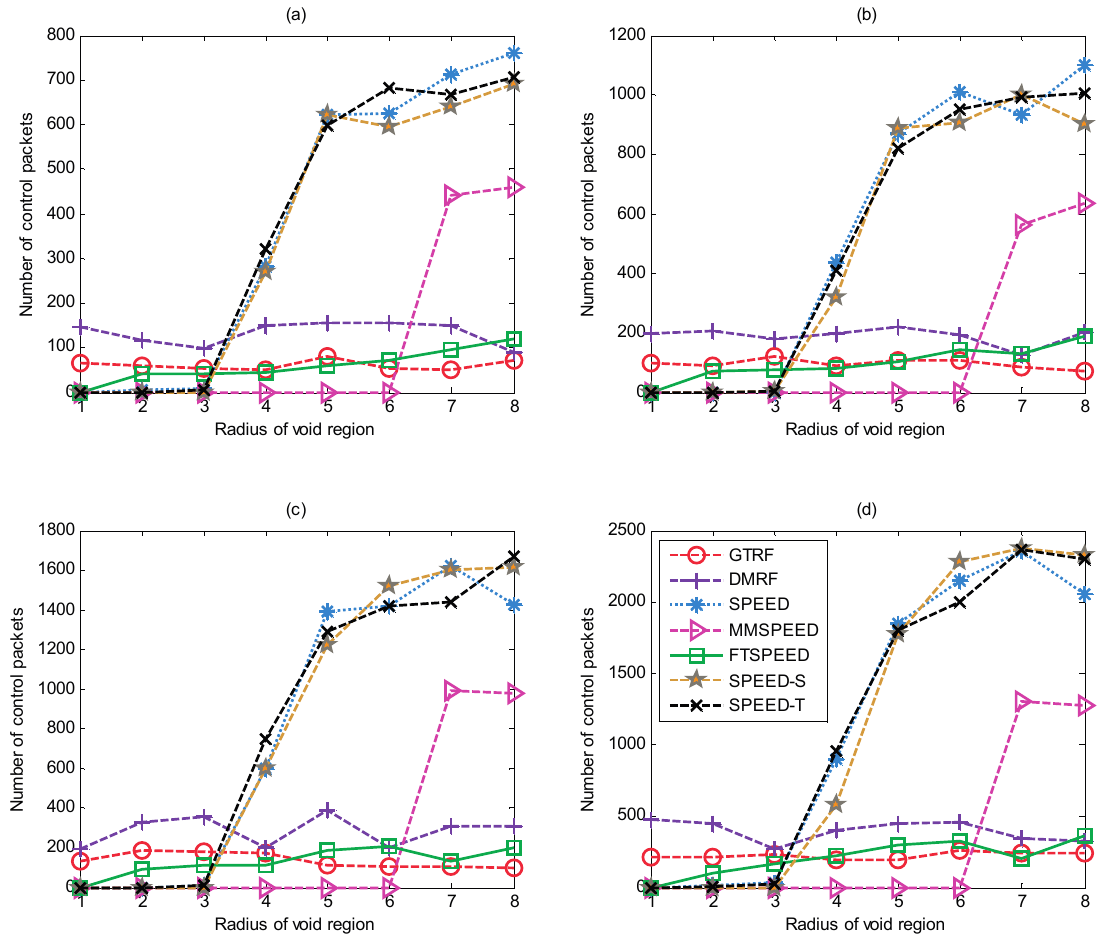
Figure 12. Number of control packets after transmitting ( a ) 1000; ( b ) 2000; ( c ) 5000 and ( d ) 10,000 packets under different routing